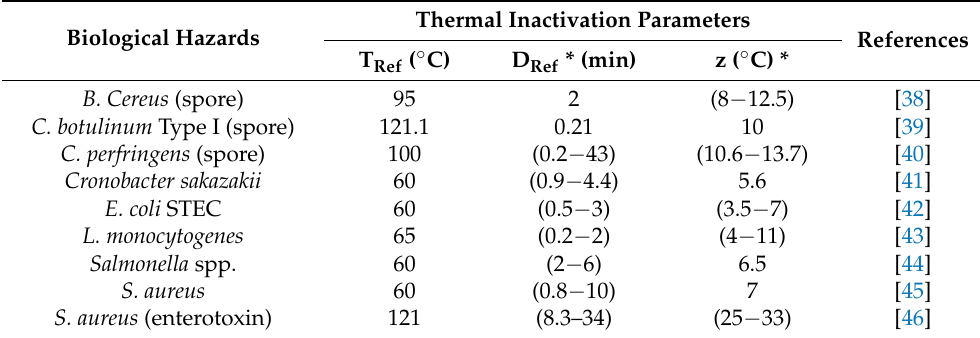
Table 3. Inactivation parameters of eight selected significant biological hazards (a w >